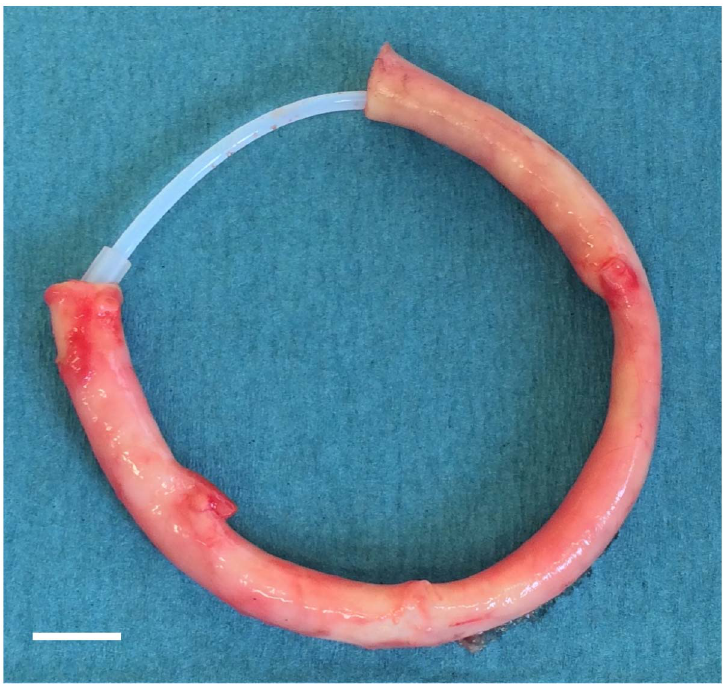
Figure 1. Intensified decellularization of equine Arteriacarotis . Native carotid artery threaded onto a Teflon tube prior to decellularization with 300 mL of detergent solution for 72 h. Scale bar: 1 cm.